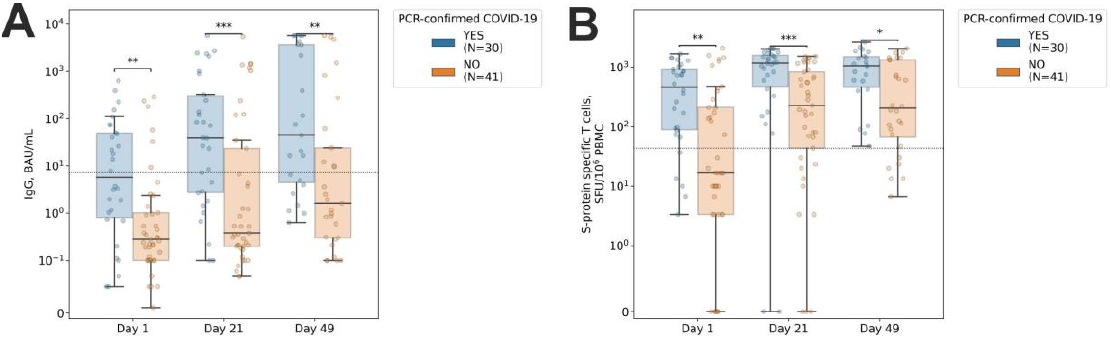
Figure 2. Dynamics of the antibody and T cell responses depending on the presence of PCR-confirmed COVID-19 prior to the vaccination. Anti-S protein IgG titers ( A ) and S protein-specific IFN γ -producing T cells ( B ) were evaluated among CLL patients prior to the vaccination on day 1 (d1), prior to the administration of the second component on day 21 (d21), and 28 days after the second component administration (d49). A symmetric logarithm (symlog) scale was used for the y-axis, with the range from 0 to the first axis tick being in linear scale, and the rest of the range in logarithmic scale. Dotted horizontal line denotes positivity threshold. 1 × 10 2 < p -values ≤ 5 × 10 2 are marked with ‘*’; 1 × 10 3 < p -values ≤ 1 × 10 2 with ‘**’; 1 × 10 4 < p -values ≤ 1 × 10 3 with ‘***’ (two -sided Mann – Whitney U test).